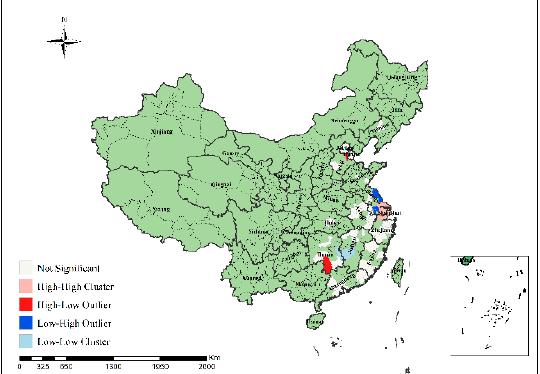
Figure 10. Local spatial autocorrelation analysis results of H7N9 outbreaks in China in 2016.